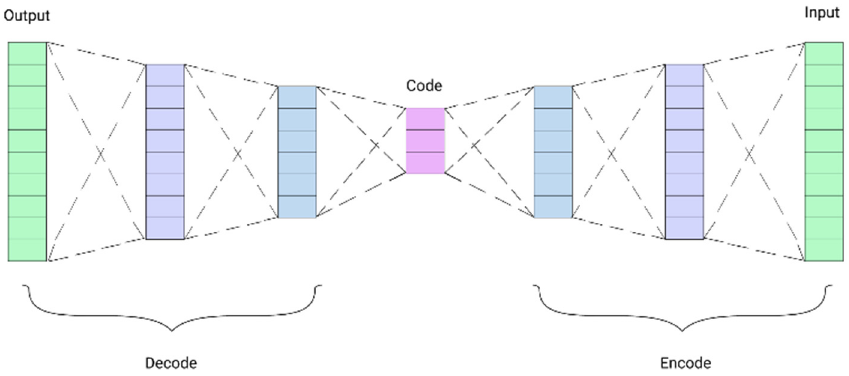
Figure 2. Structural diagram of autoencoder model, adopted from [46]. Table 3. Sparse autoencoder parameters.